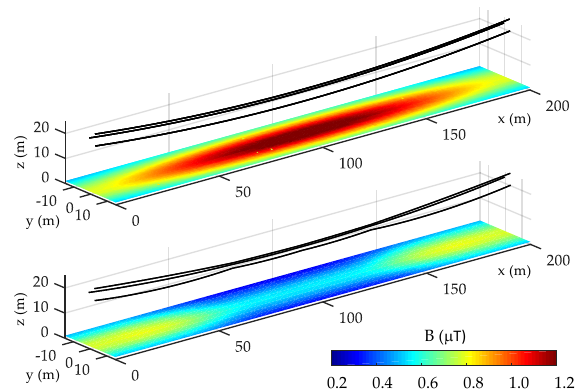
Figure 5. Magnetic induction B on a plane 1 m above the ground level, without compactors ( above ) and with three compactors ( below ).